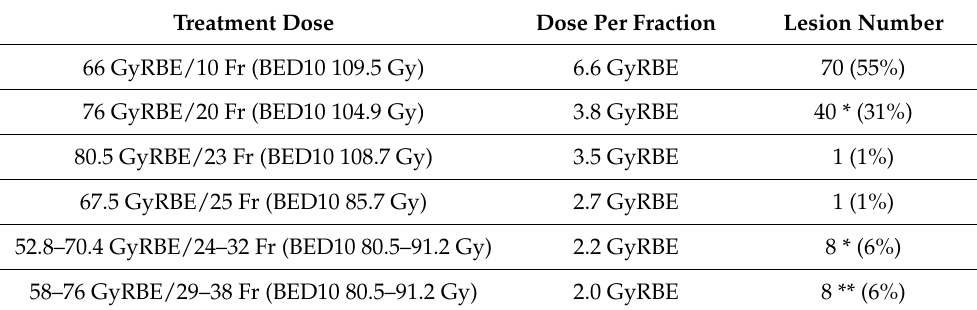
Table 3. Treatment